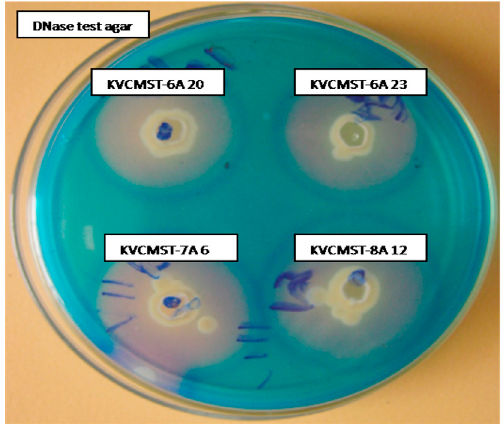
Fig. 1. Extracellular DNase activity of the selected isolates on DNase test agar with toluidine Table 5. DNase production for KVCMST-6A23 at various NaCl concentrations on DNase test agar NaCl DNase test Zone Optical Density concen. diameter in mm